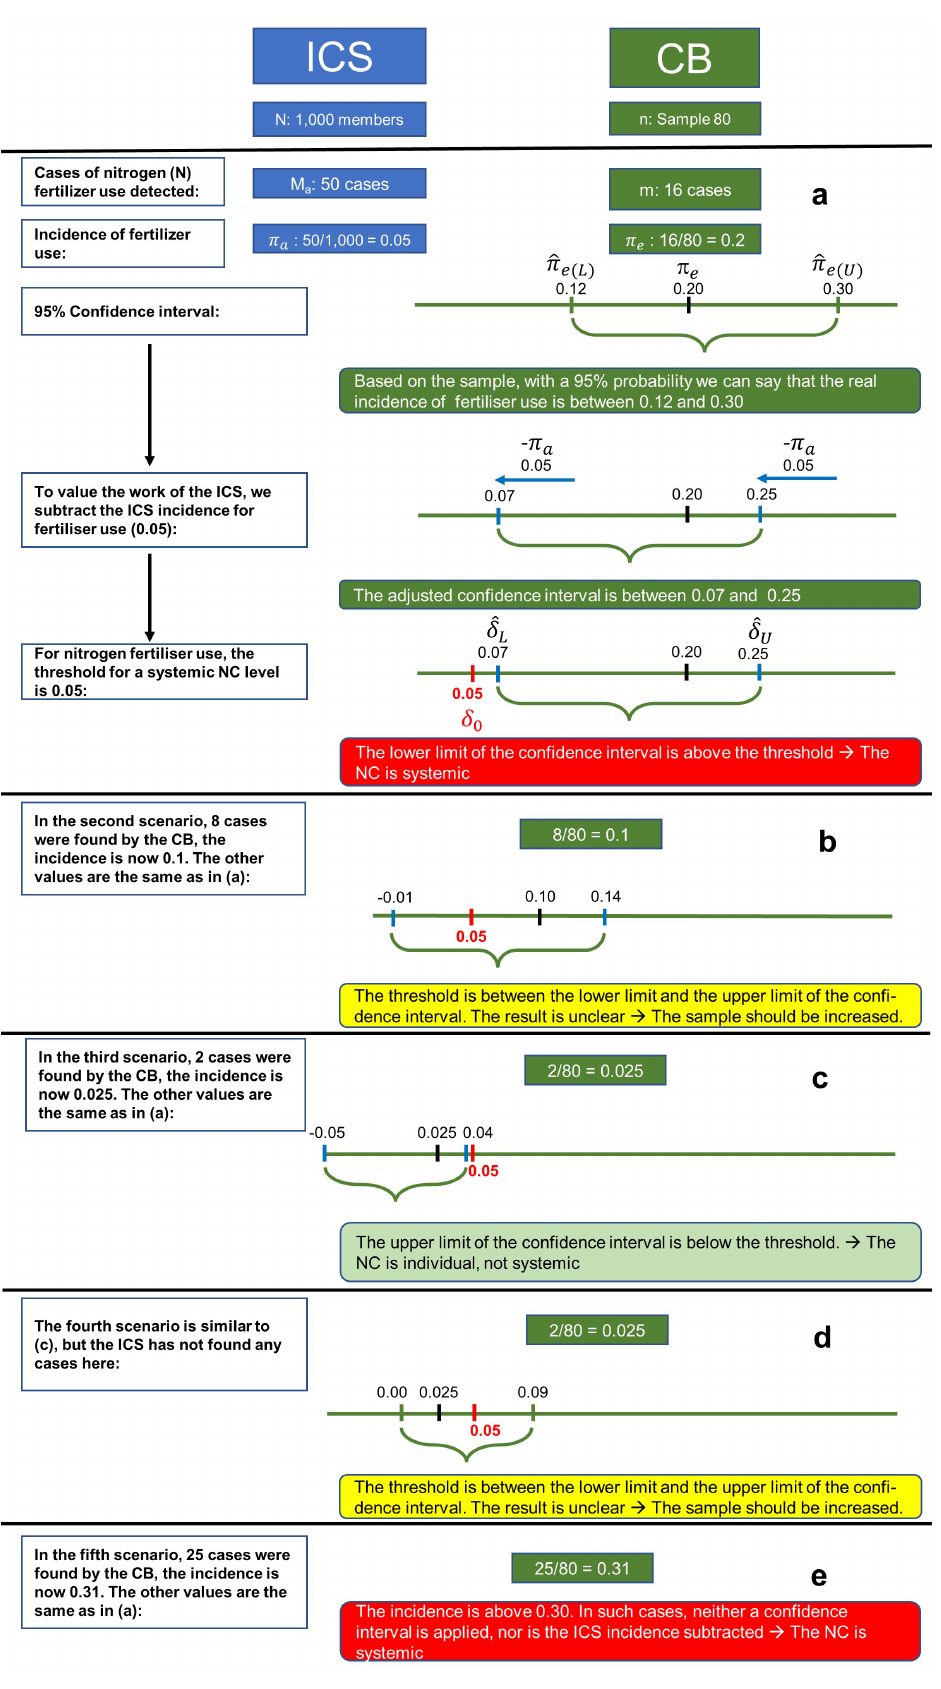
Figure 5. Five scenarios illustrating the procedure described in Section 4 The incidence of a specific NC (in this example synthetic nitrogen fertiliser use) found by the CB, the meaning of the confidence interval, and how the outcome can be affected by the performance of the